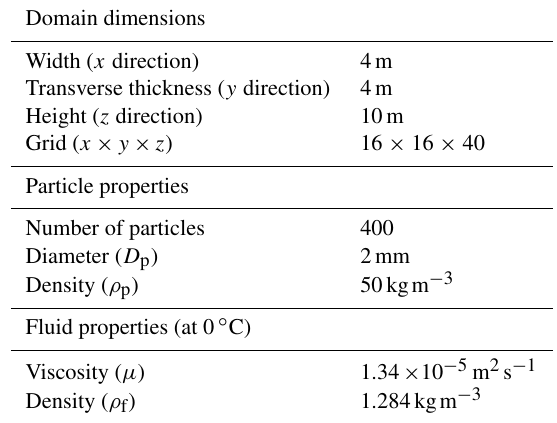
Table 2. Domain size and fluid and particle properties of simula- tions.